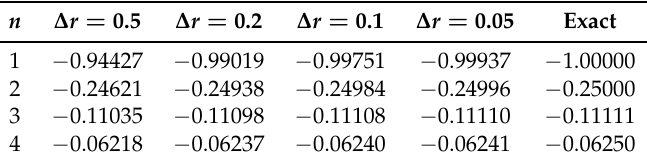
Table 1. Numerical Eigenvalue